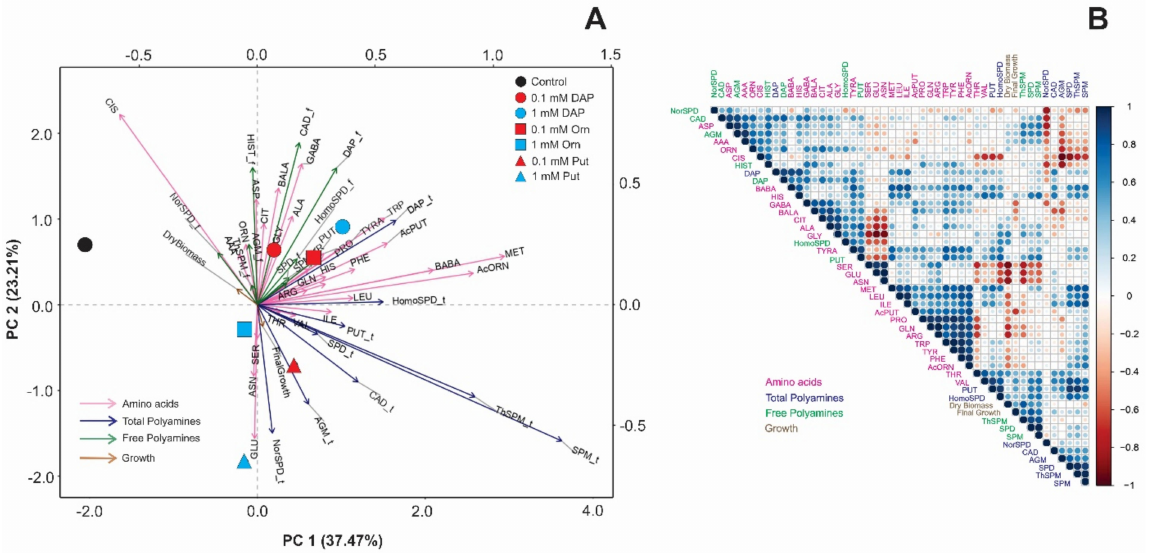
Figure 4. Principal components analysis (PCAs) ( A ) and correlation matrix ( B ) of the N-containing metabolites [free amino acids (pink arrows), total polyamines (blue arrows), free polyamines (green arrows)] and growth (dry biomass and final growth) in Arabidopsis thaliana (Col-0 ecotype) seedling from unprimed (control, black circle) or primed seeds with DAP (circles), Orn (square), or Put, (triangle) at two concentrations [0.1 mM (red symbols) or 1 mM (blue symbols)] grown under optimal conditions. Data were normalized using the natural logarithm. Each geometric figure (circle, square, and triangle) represents the mean values of four biological replicates ( n = 4). Blue and red colors in the correlation matrix indicate positive and negative values,